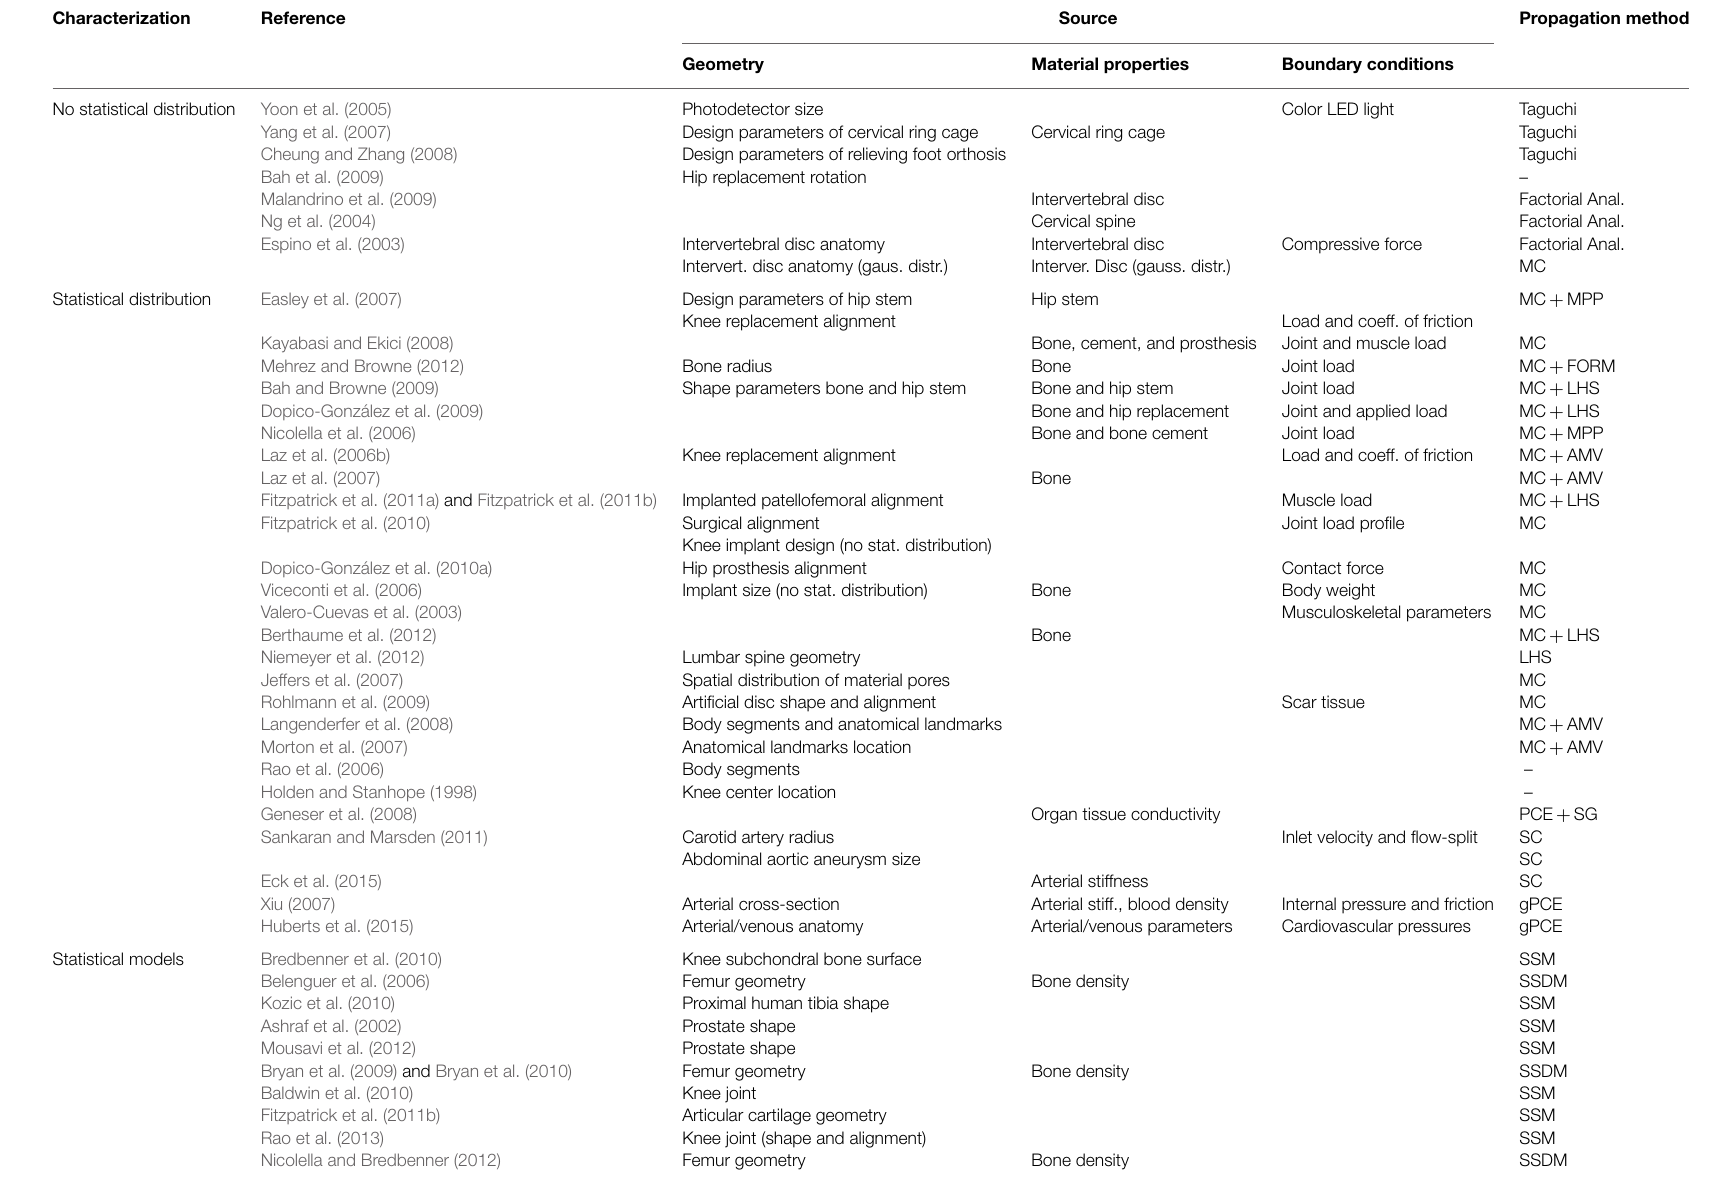
TABLE 2 | Uncertainty studies according to the source of uncertainty and its characterization in the context of biomedical computational analysis